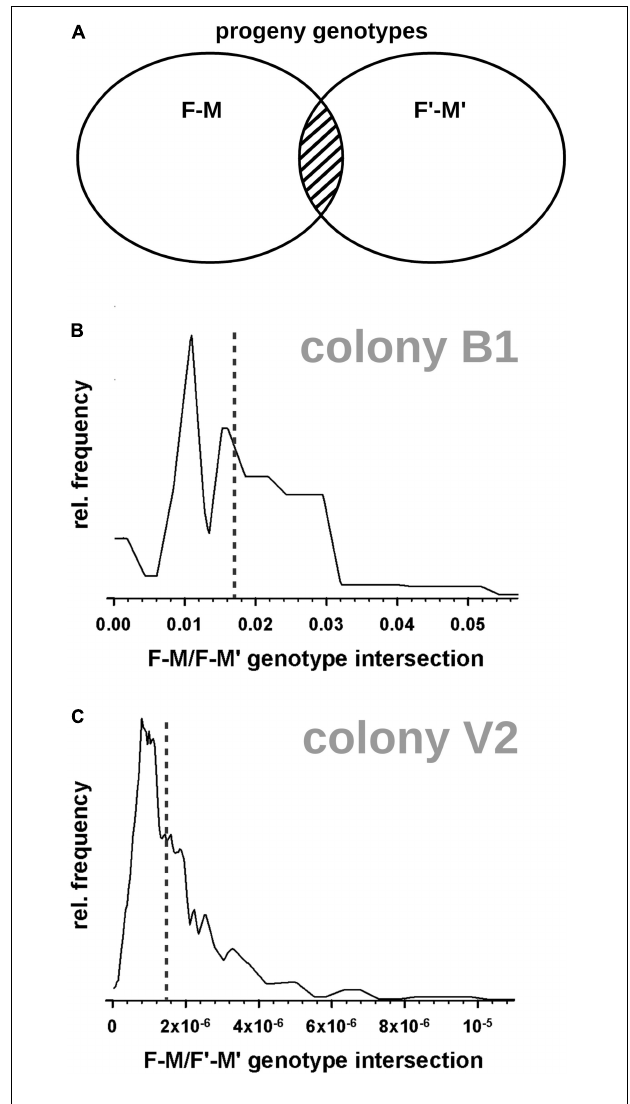
FIGURE 1 | Probabilistic model for ambiguous parental relationships underlying the exclusion test II. A known female parent (F or F’) and a candidate male parent (M or M’) were evaluated for possible progeny genotypes they may generate. (A) Two alternative parent pairs (F-M and F’-M’) produce progeny genotypes ( circles ), which may intersect ( striped region ). (B,C) Histograms showing the full distribution of the individually calculated progeny genotype intersections, for alternative parental animals (F’ or M’ in panel A ) compared to the universally consistent breeding animals in a colony (F-M in panel A ). The size of the intersection ( x -axis) is scaled as fraction of genotype space F-M. (B) Alternative breeding males in colony B1; median intersection 0.017 (dotted vertical line). (C) Alternative breeding pairs (F’-M’) in colony V2; median intersection 0.0000015 (dotted vertical